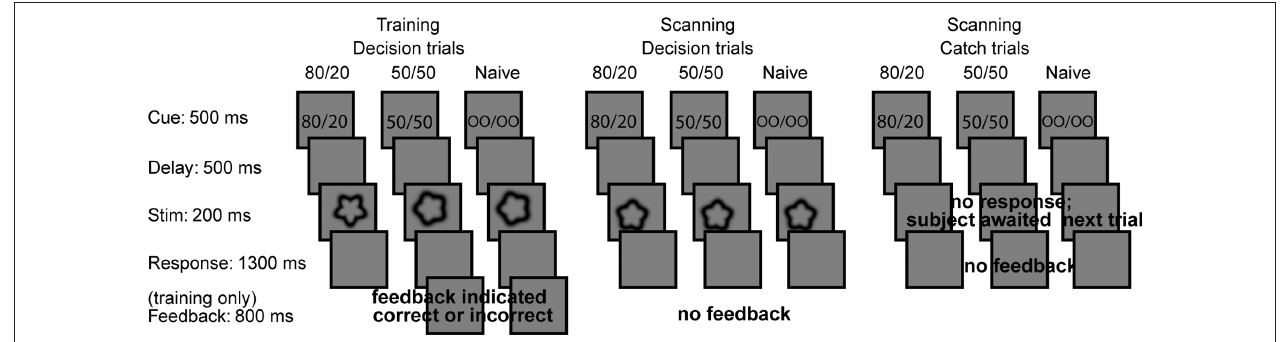
the delay and response epochs of both decision and catch